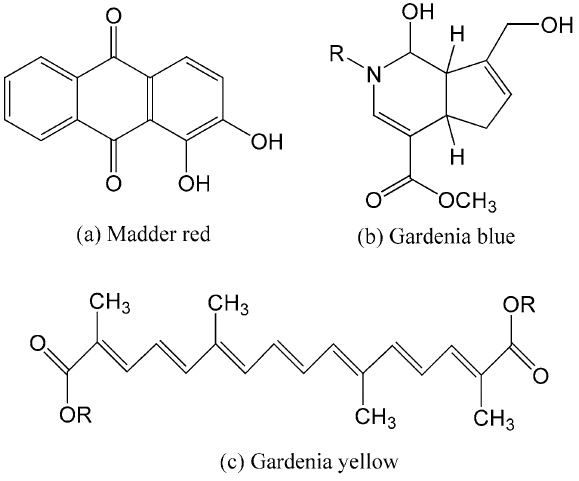
Figure 1. Chemical structures of main components of ( a ) madder red, ( b ) gardenia blue, and ( c ) gardenia yellow